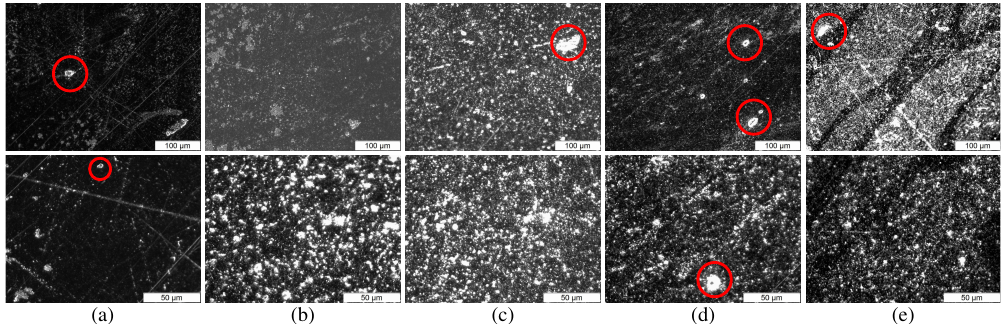
Figure 10. Microscope images of tensile test specimen cross-sections of ( a ) pure ABS, ( b ) 10 vol %, ( c ) 20 vol %, ( d ) 30 vol % and ( e ) 35 vol % at (top row) 20 × and (bottom row) 50 × zoom. Some visible voids have been marked with red